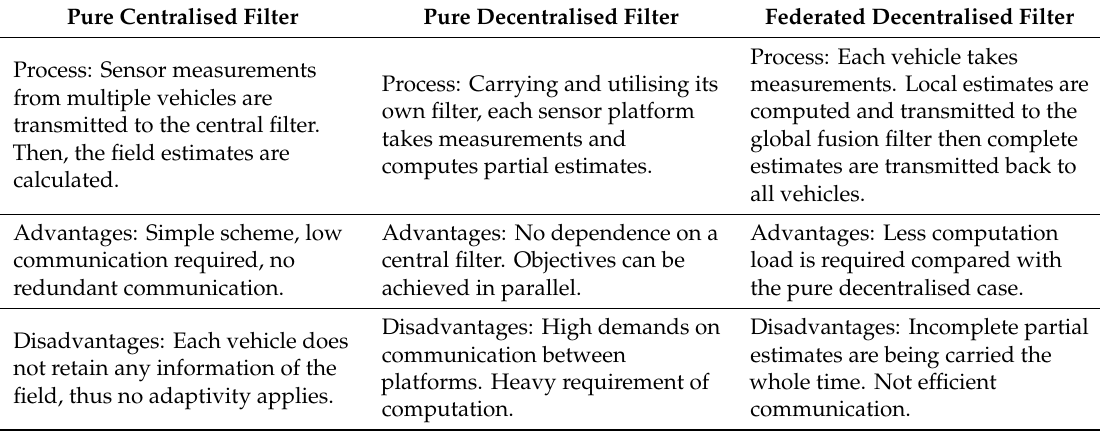
Table 16. Comparison of three schemes of Kalman filters (KF) in the adaptive sampling algorithm. Pure Centralised Filter Pure Decentralised